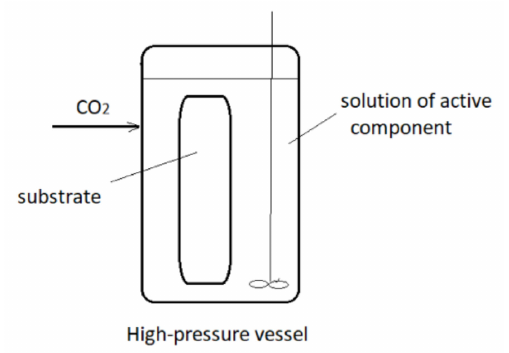
Figure 4. Simplified presentation of Supercritical Assisted Impregnation (SAI) / High-Pressure Assisted Impregnation (HPAI)